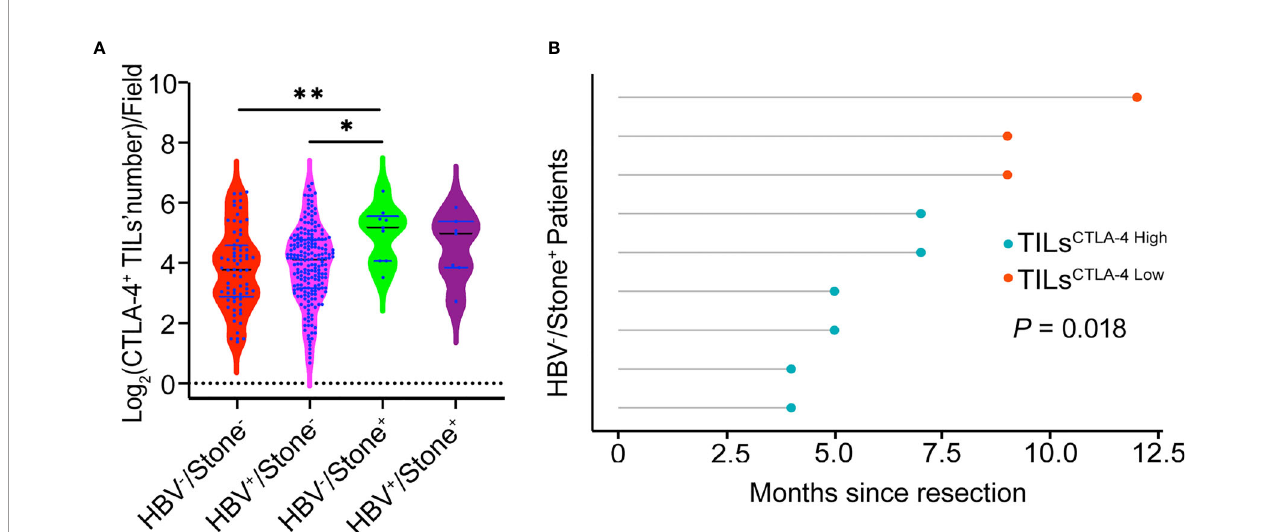
FIGURE 4 | Relationship of the density of CTLA-4 + TILs to risk factors and prognosis. (A) Patients with HBV - /Stone + ICC had a higher density of CTLA-4 + TILs in tumor samples compared with patients with HBV + /Stone - ICC and HBV - /Stone - ICC. (B) Patients with TILs CTLA-4 High show a reduced OS compared with patients with TILs CTLA-4 Low among nine patients with HBV - /Stone + ICC. * P < 0.05 and ** P <